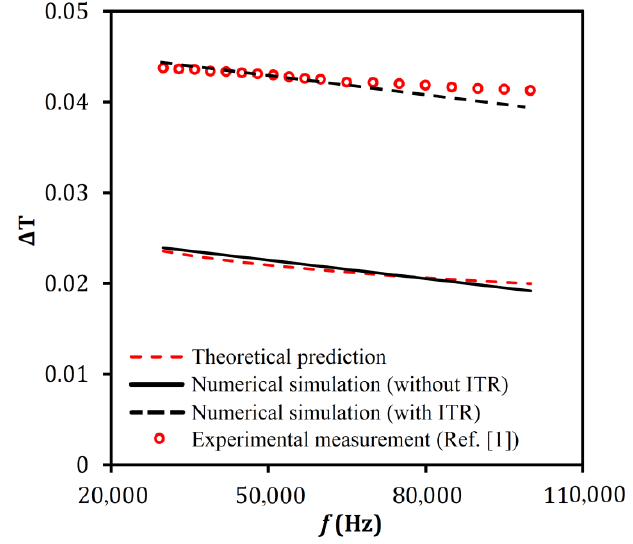
Figure 10. A comparison among the numerical simulation, theoretical prediction, and experimental results on Δ T versus f .